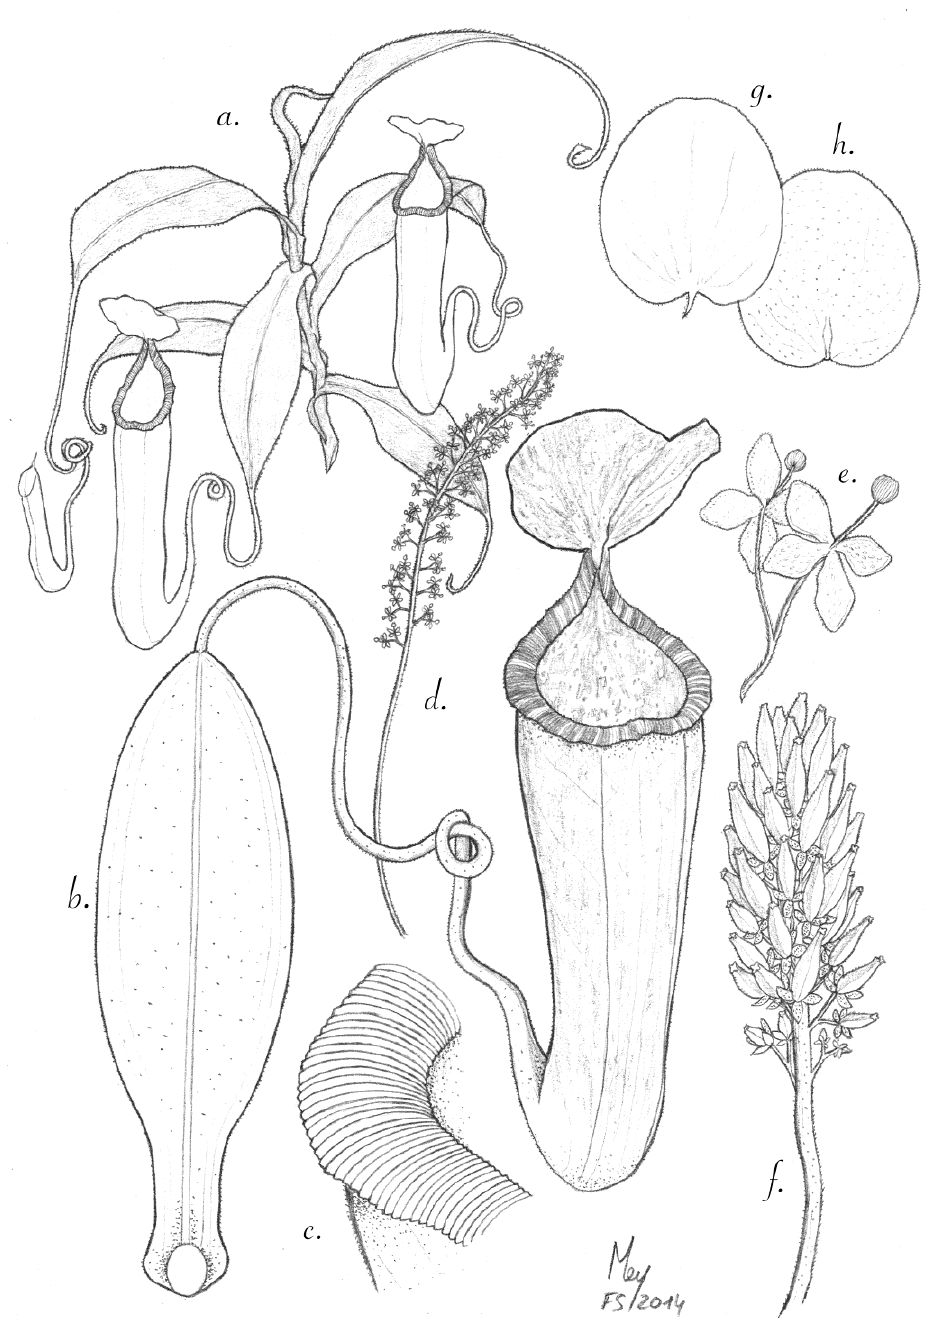
Figure 4. N. amabilis . ( a ) Habit with upper pitchers; ( b ) leaf with upper pitcher; ( c ) detail of peristome; ( d ) male inflorescence; ( e ) partial inflorescence with male flowers; ( f ) infructescence; ( g ) the upper surface of lid with spur; ( h ) the underside of the lid. Rosette plants with lower pitchers could not be identified with certainty at the type locality and are thus not